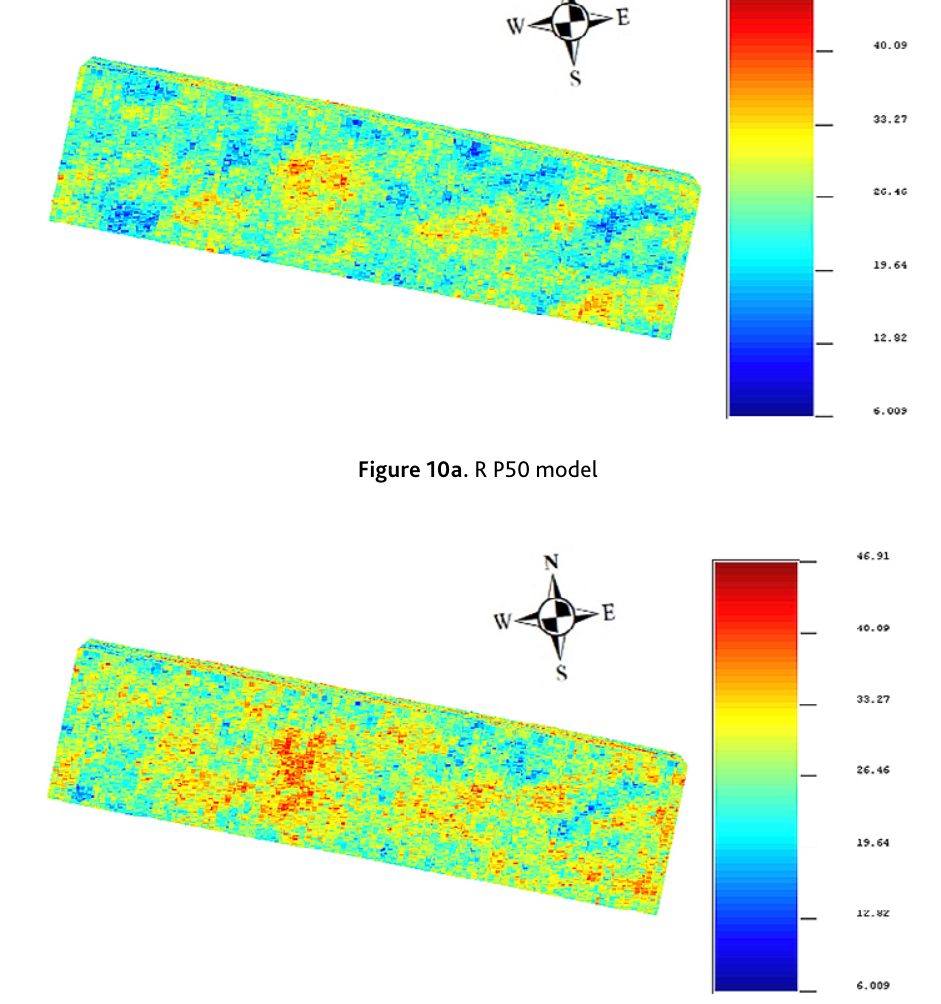
Figure 9f. R Realization Example #6